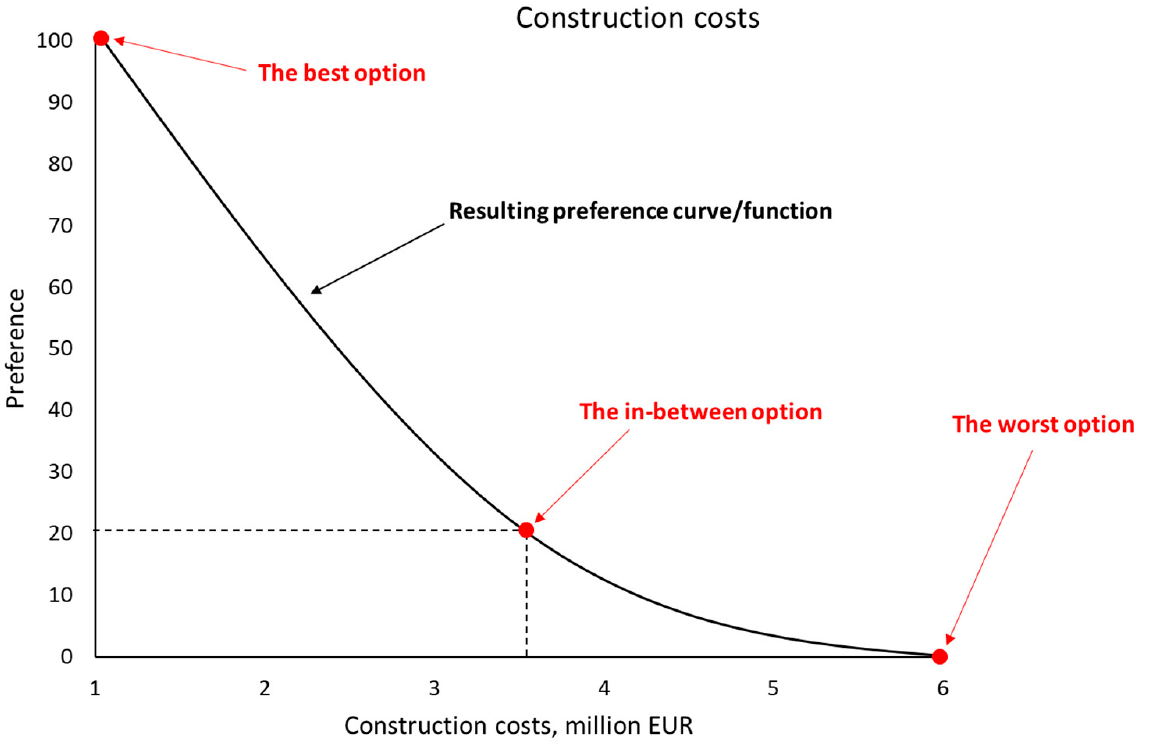
Figure 2. An example of obtaining a preference curve.